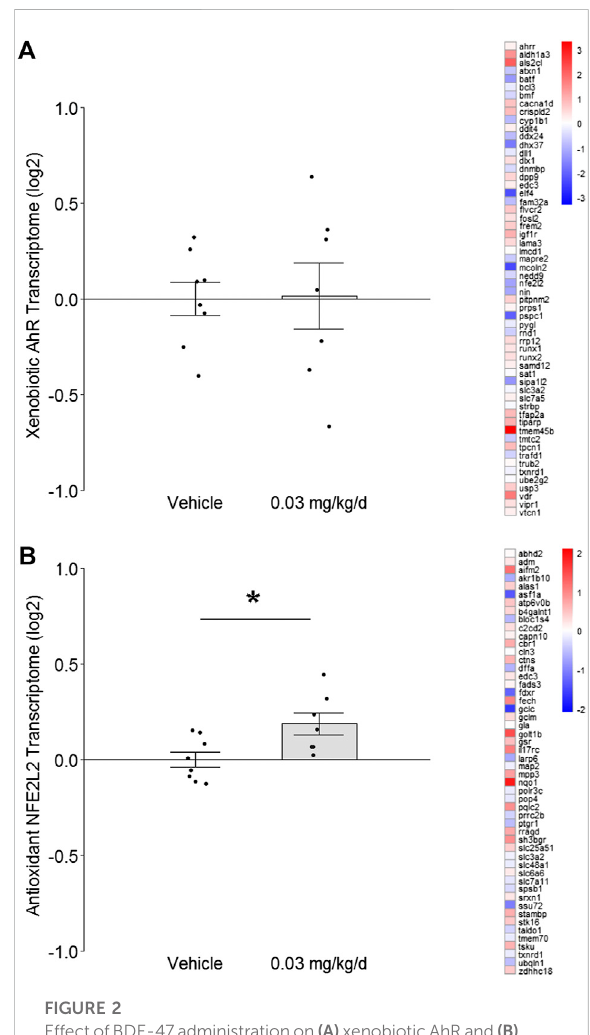
FIGURE 2 EffectofBDE-47administrationon (A) xenobioticAhRand (B) antioxidant NFE2L2 transcriptomes in mammary tissue. Left side: Mean ± SEM with overlay of individual TRA composite score data points, scores on log2 scale centered at zero, n = 7-8 mice per group. Right side: Heatmap of mean fold-changes on log2 scale for speci fi c positively expressed genes from the reference transcriptome indicated in the panel. See text